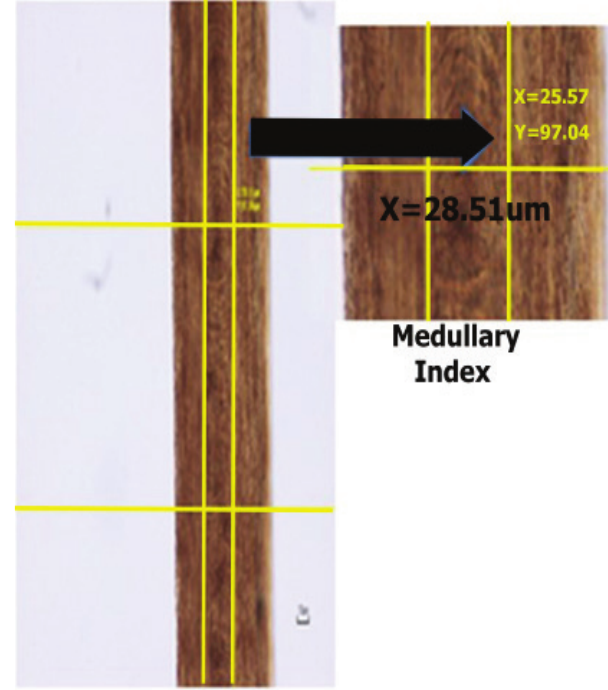
Figure-IV: Hair shaft with a calculation of the medullary